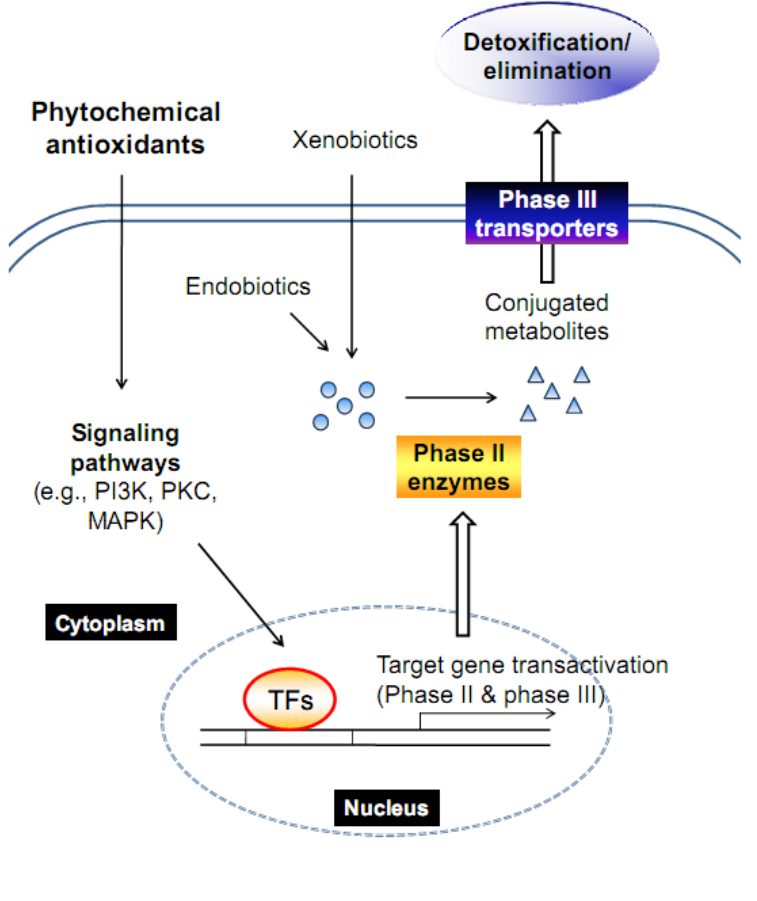
Figure 3. A schematic representation of the mechanism by which phytochemical induces target